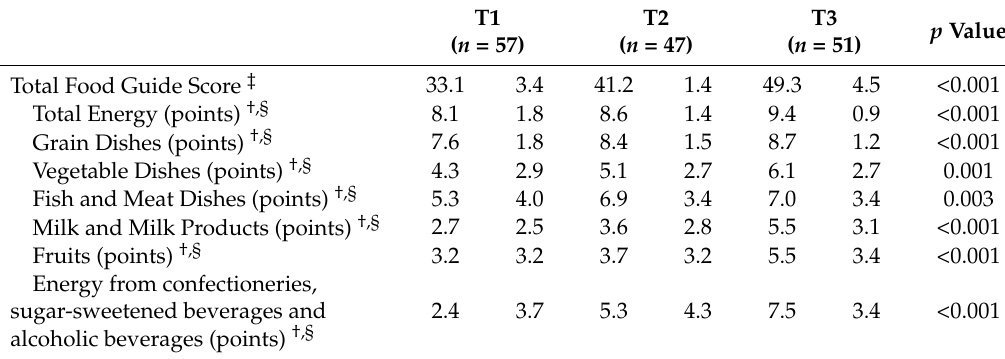
Table 2. Association between the Food Guide score, specific Food Guide score, and intake of nutrients and food